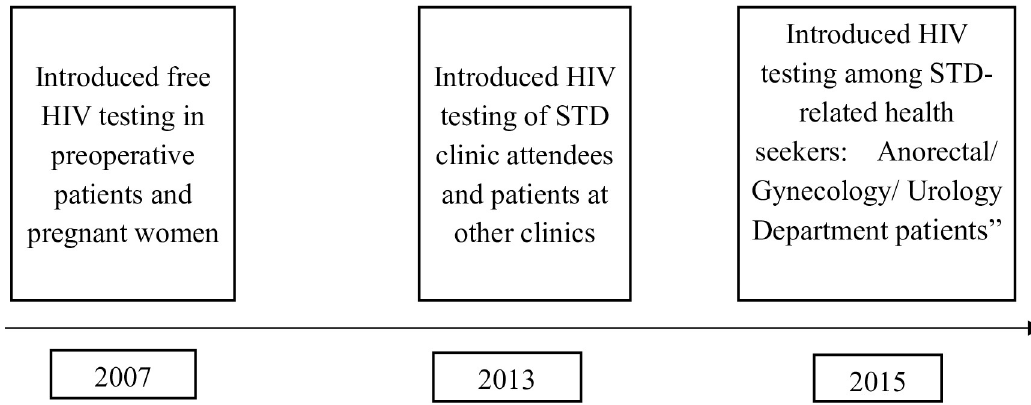
Fig 1. HIV screening strategy in medical institutions from 2007 to 2015. This fig shows the change of HIV screening strategy from 2007 to 2015. It helps the reader understand the results of this study.